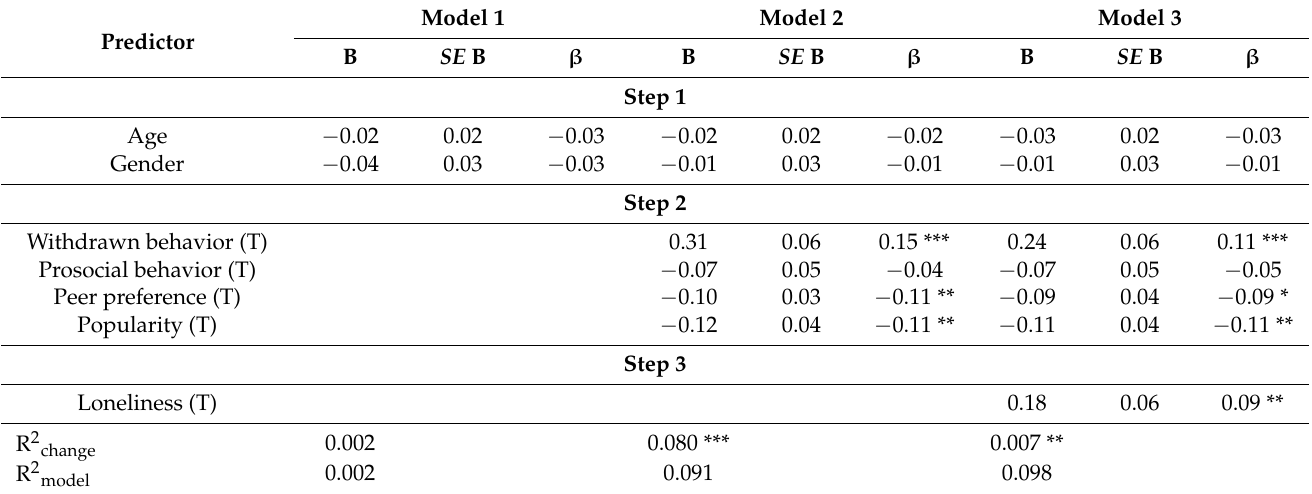
Table 2. Hierarchical Regression Model of Social Characteristics and Loneliness Teacher Nominations Predicting Self- Reported